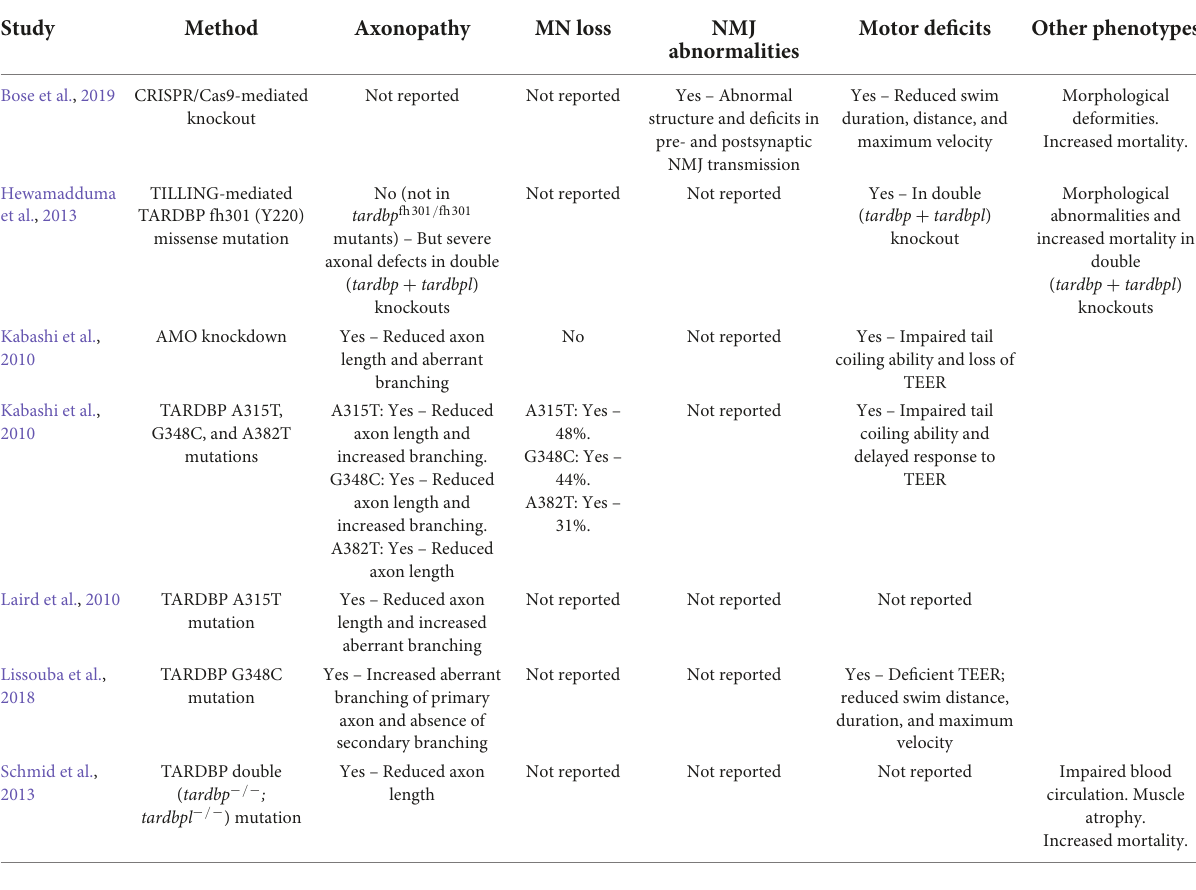
TABLE 6 Zebrafish models of TARDBP (TDP-43) pathology.